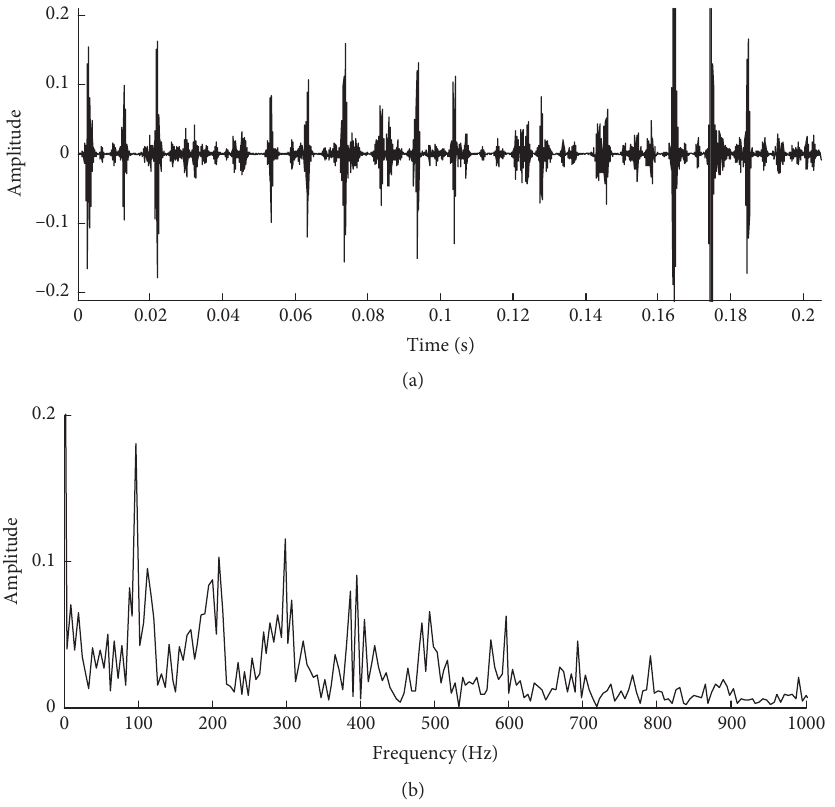
Figure 8: Low resonance component and its envelope spectrum of x after